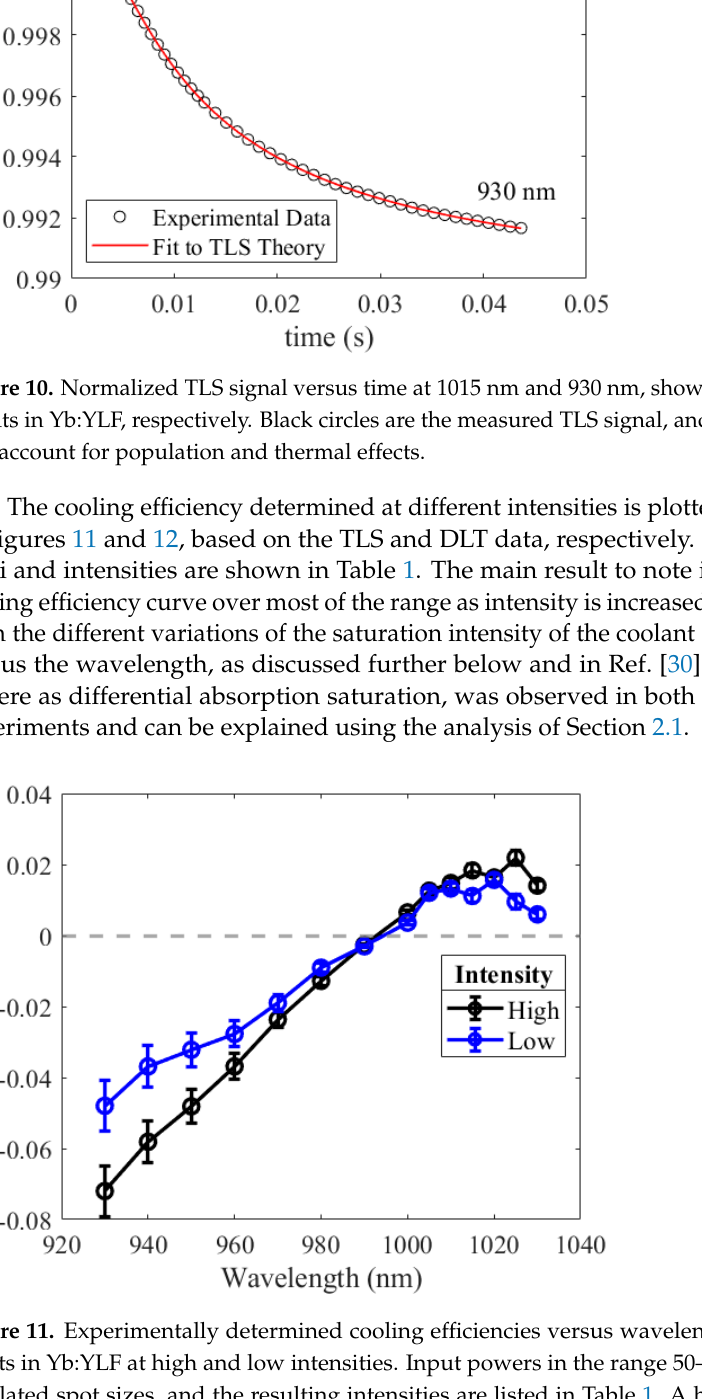
Figure 11. Experimentally determined cooling efficiencies versus wavelength from TLS measure- ments in Yb:YLF at high and low intensities. Input powers in the range 50–530 mW focused to the tabulated spot sizes, and the resulting intensities are listed in Table 1. A host parameter value of Θ = 1.4 W − 1 was used for analysis at all intensities. For low and high intensity data, the external quantum efficiency and the background absorption coefficient determined from fitting the data to Equation (10) were η ext = 1.01 ± 0.02 and α b = ( 4 ± 2 ) × 10 − 3 cm − 1